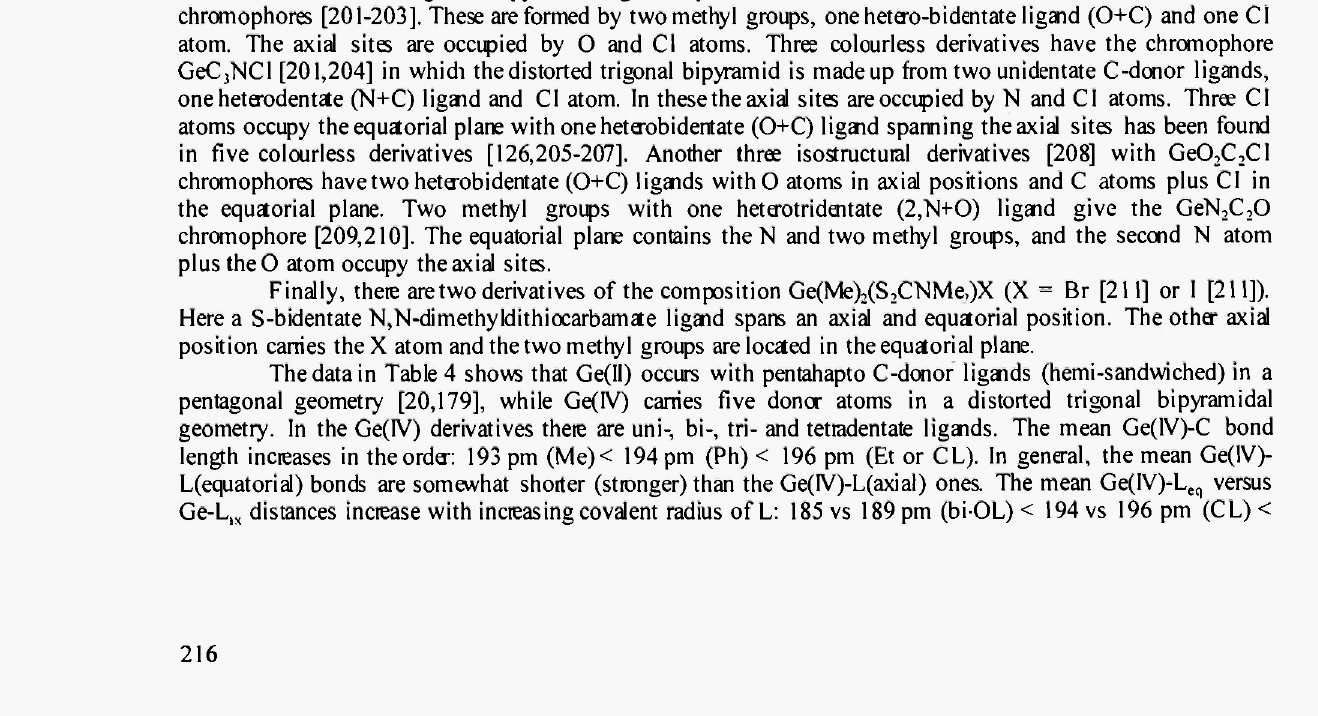
Fig.4. Structure of Ge{N(CH 2 CH 2 0) 2 (CP(0)Et 2 }{CH 2 CH 2 (Me)C00}